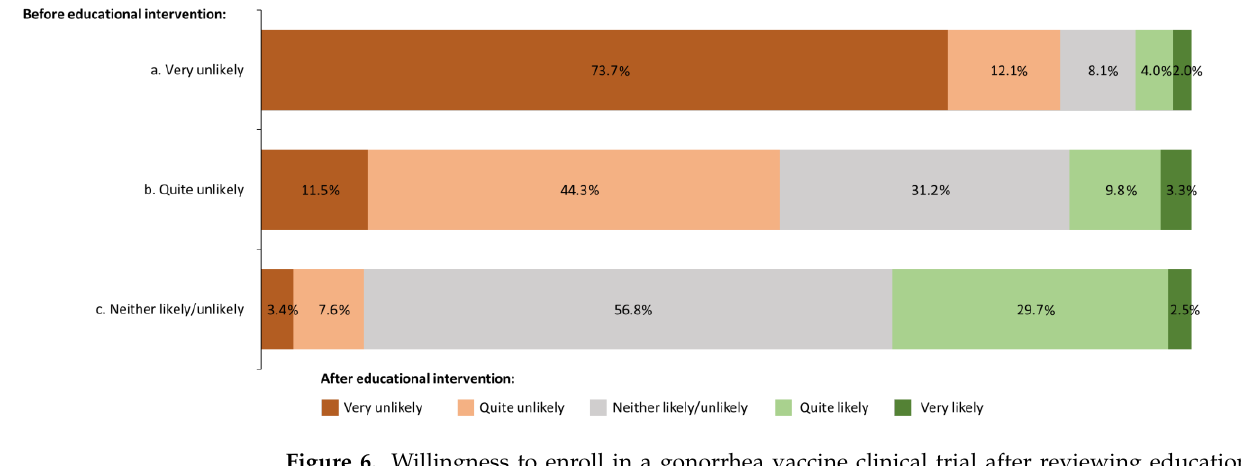
Figure 6. Willingness to enroll in a gonorrhea vaccine clinical trial after reviewing educational information according to those initially selecting ( a ) very likely ( n = 99), ( b ) quite likely ( n = 61), and ( c ) neither likely/unlikely ( n = 118). Difference in post-pre educational intervention: −2 (1.4%), −1 (5.8%), 0 (60.1%), 1 (23.7%), 2 (6.1%), 3 (2.2%), and 4 (0.7%); Wilcoxon signed rank test p < 0.001.